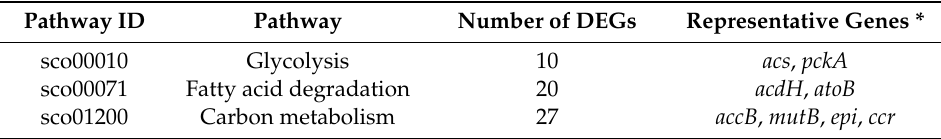
Table 3. Selected KEGG enrichment results of DEGs between strains ST042 and